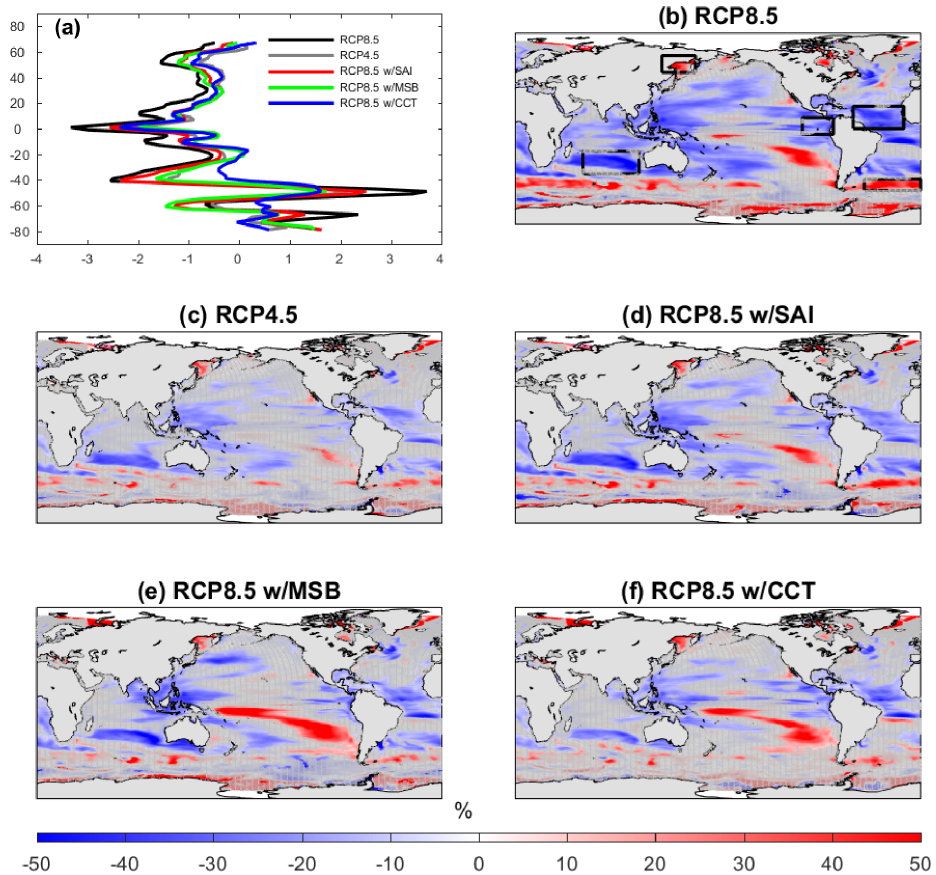
Figure 6. The percent changes in NPP in 2071–2100 relative to the 1971–2000 average in the historical run. (a) Zonally averaged (in 2 ◦ latitude bands) change for all simulations. (b) RCP8.5, (c) RCP4.5, (d) RCP8.5 with SAI, (e) RCP8.5 with MSB, (f) RCP8.5 with CCT. Gray shading in panels (b–f) indicates areas where the change is not significantly different from the 1971–2000 average (i.e., within 1 standard deviation of the 1971–2000 mean). The outlined areas in panel (b) indicate regions plotted in Fig. 9.